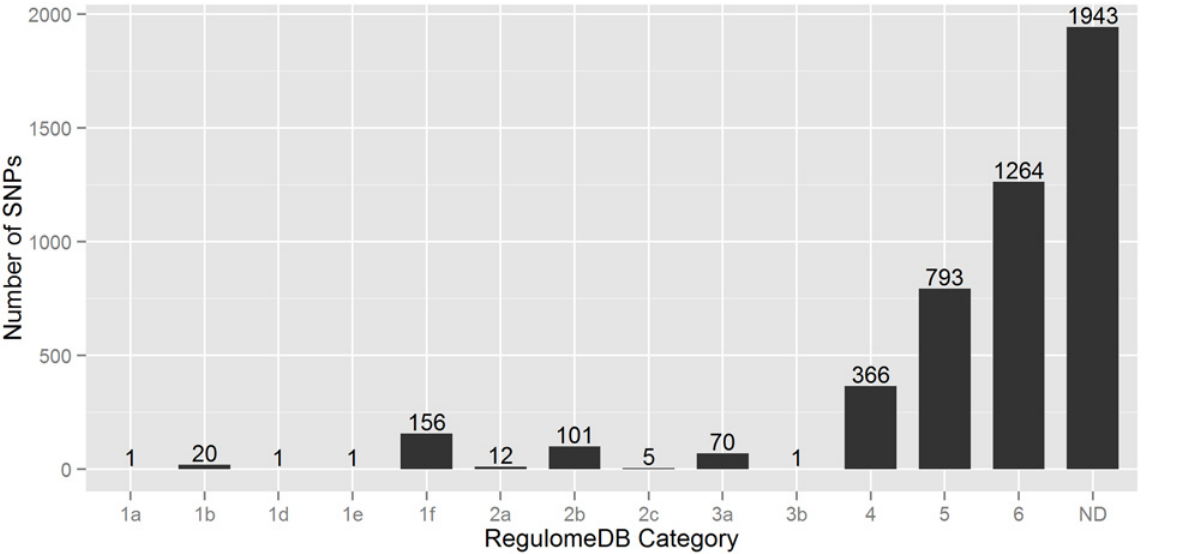
Fig 4. Bar diagram representing the number of SNPs in each RegulomeDB category. Here n = 4734 variants. ND : No